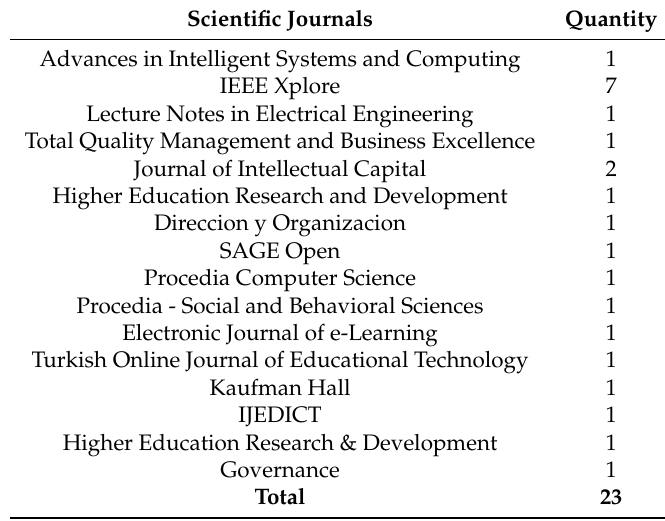
Table 4. Scientific journals of selected